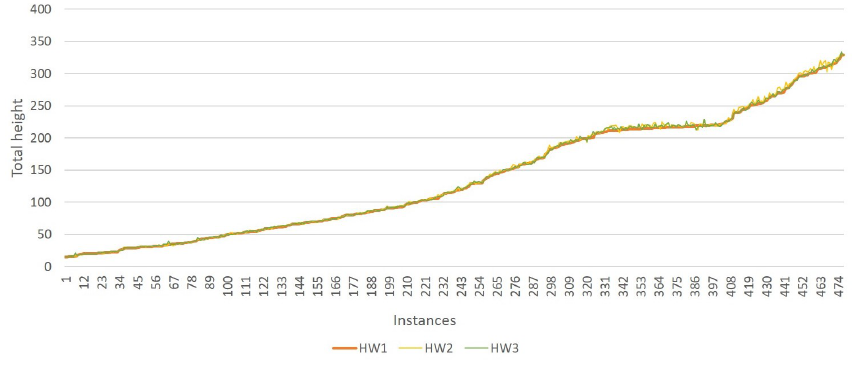
Figure 7. Waste performance